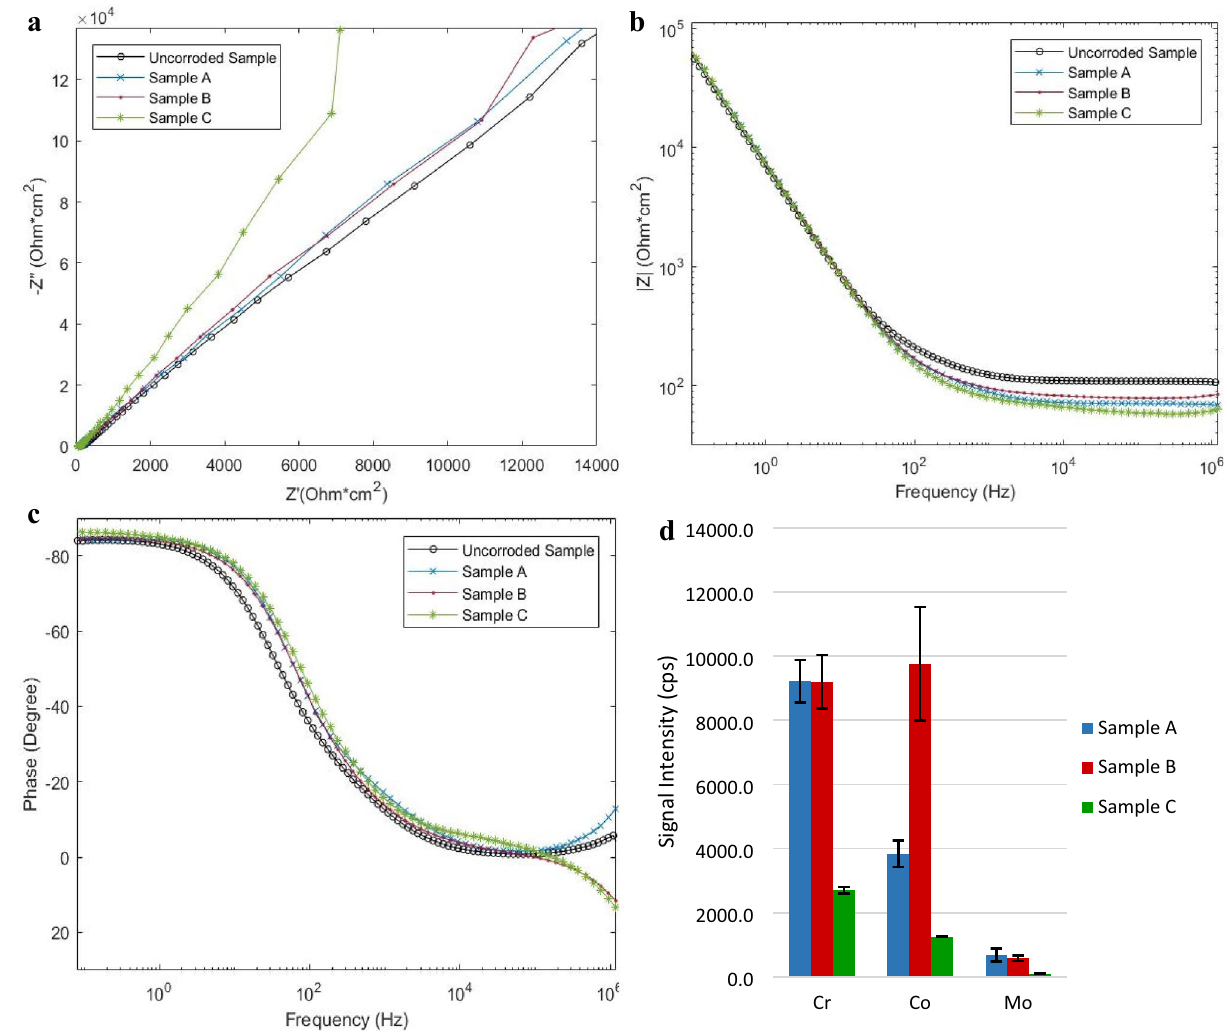
Figure 6. Area normalized Electrochemical impedance spectroscopy (EIS) analysis and relative metal ion concentration in the simulated synovial fluid at test completion. EIS analysis of the corroded samples in original test simulated synovial fluid. The uncorroded sample represents a freshly prepared, non-corroded test specimen. Sample A was shielded from electrical activity, Sample B was subjected to a 50 MHz, 200 mVpp sine wave, and Sample C was subjected to a 25 MHz, 200 mVpp square wave. ( a ) Comparison of positive real impedance (x-axis) and negative imaginary impedance (y-axis). ( b ) Total magnitude of impedance (y-axis) is plotted against frequency (x-axis). ( c ) Phase angle (y-axis) is plotted against frequency (x-axis). ( d ) Base metal ion concentration intensity in the simulated synovial fluid after testing from laser ablation inductively coupled plasma mass spectroscopy